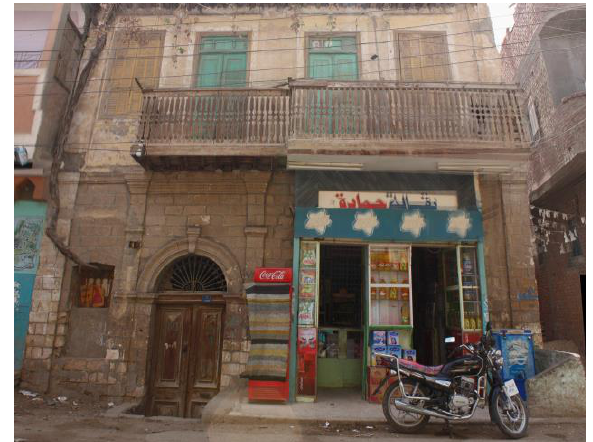
Figure 10. Two story building, plastered and semi